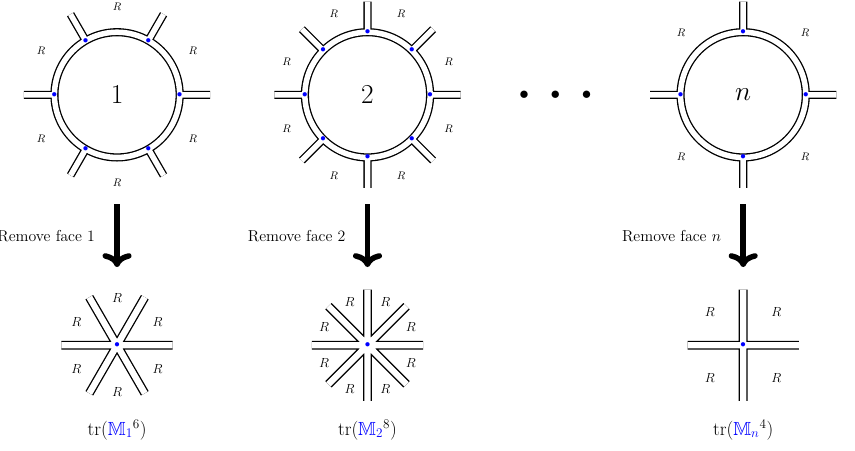
Figure 28 . Integrating-out all faces except the reservoir R